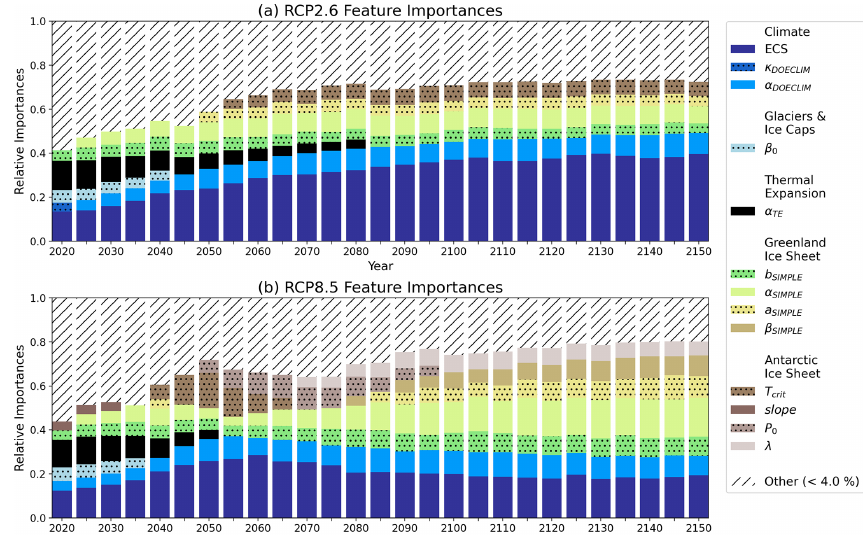
Figure A1. Relative feature importances of the BRICK model parameters calculated based on the random forests fitted when defining the high-end threshold as the 80th percentile of the data. Shown are the importances of the BRICK model parameters using (a) the RCP2.6 radiative forcing scenario and (b) the RCP8.5 forcing scenario. All model parameters with an importance less than 4% were grouped into an “other” category, which is shown with hatch marks to denote its difference from the parameters. Stippling was added to alternating parameters in the legend to aid in telling the difference between similar colors.